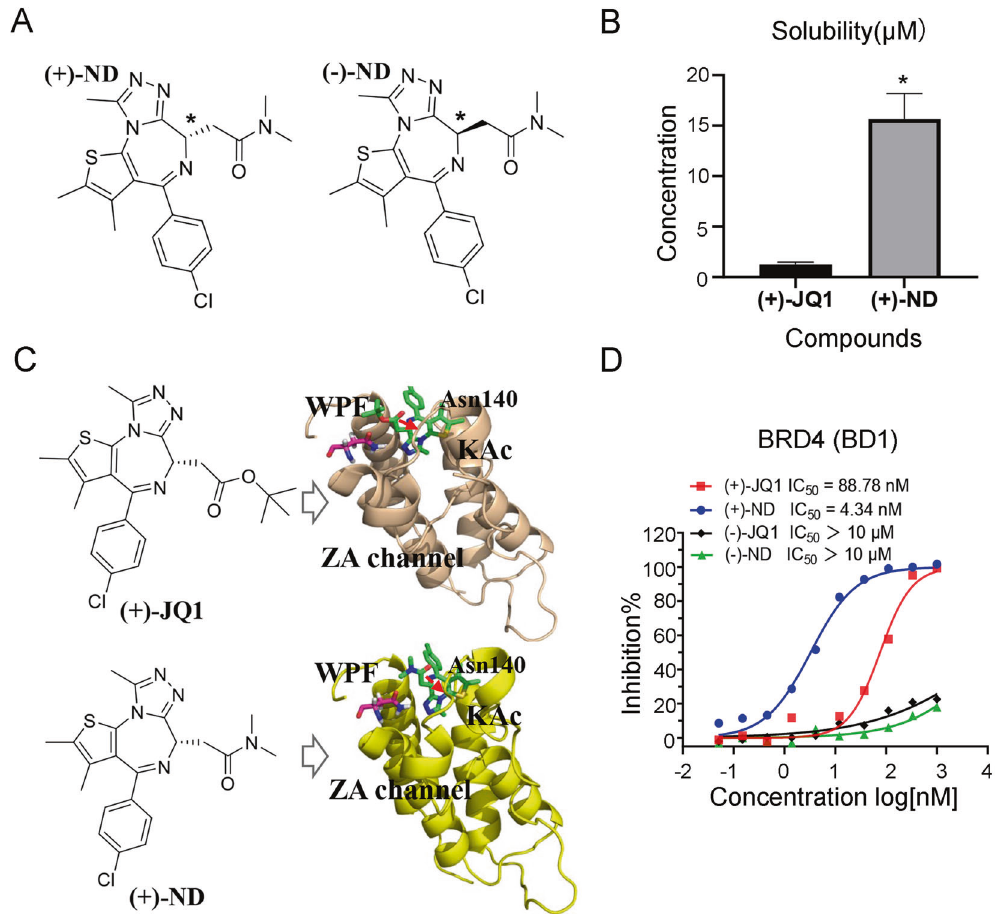
Fig. 1 Identi fi cation of ( + )-ND as a potent inhibitor of BRD4. A The structures of enantiomers ( + )-ND and (-)-ND. B The water solubility of ( + )-JQ1 and ( + )-ND. * P < 0.05 relative to the control. C The binding models of ( + )-JQ1 and ( + )-ND with BRD4 (PBD: 3MXF), respectively. D The inhibitory activities of different enantiomers toward BRD4